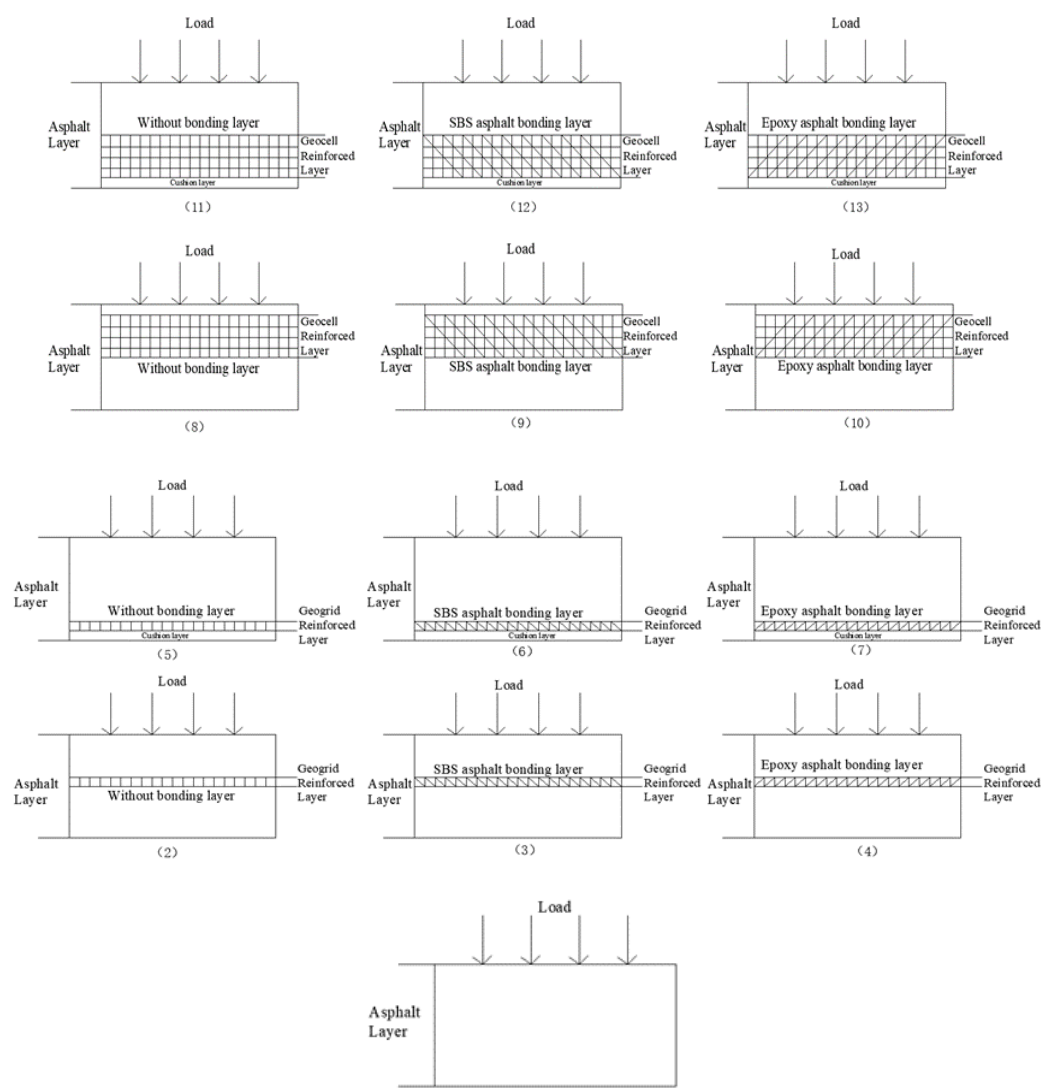
Figure 2. Reinforcement scheme of geosynthetics.